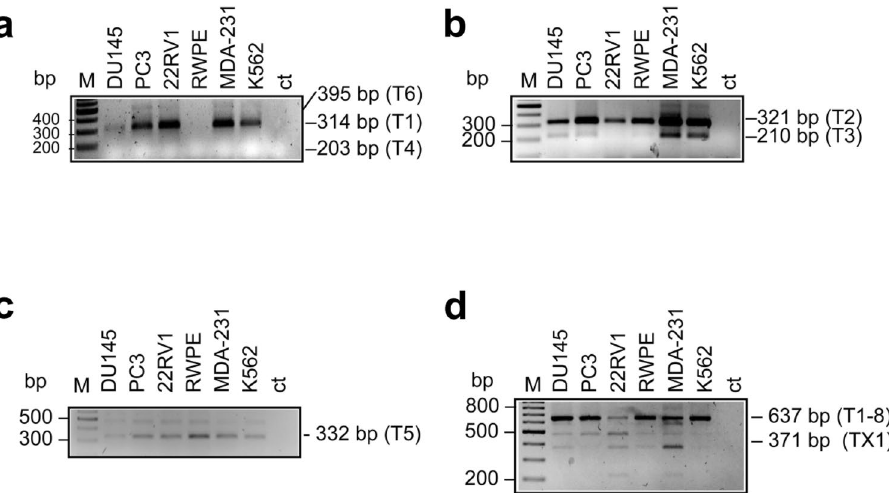
Figure 2. Specific RT-PCR for detection of the ETV4 transcripts reported in the NCBI RefSeq database in selected cell lines (Du145, PC3, 22RV1, RWPE, MDA-231 and K562). ( a ) RT-PCR to detect Transcript 1 (T1, 314 bp), Transcript 4 (T4, 203 bp) and Transcript 6 (T6, 395 bp). Primers are located in the 5’UTR common to transcripts 1, 4 and 6, and in exon 5. The 314 bp amplicon (Transcript 1) was present in all the analyzed cell lines, except RWPE, while the 203 bp (Transcript 4) and the 395 bp (Transcript 6) amplicons were not detected in any of them. The band corresponding to the 314 bp amplicon may include also Transcripts 7 and 8, which differ from Transcript 1 for the deletion of few nucleotides. ( b ) RT-PCR to detect Transcript 2 (T2, 321 bp) and Transcript 3 (T3, 210 bp). Primers are located in the 5’UTR common to transcripts 2 and 3, and in exon 5. The 321 bp amplicon (Transcript 2) was present in all the analyzed cell lines. The 210 bp amplicon (Transcript 3) was present in all the analyzed cells (faint in RWPE) but in 22RV1. ( c ) Transcript 5 (T5, 332 bp) was detected in all analyzed cells. Primers are located in the 5’UTR of transcripts 5, and in exon 5. ( d ) RT-PCR to detect Transcripts 1 to 8, but 5, (T1-8, 637 bp) and Transcript X1 (371 bp), which were present in all the analyzed cells. Primers are located in exon 6 and in exon 10. The presence of additional amplicons suggests the existence of other alternative transcripts such as ETV4 ∆7 (475 bp), see Fig. 4. Primer sequences for the specific amplification of each transcript are reported in Supplementary Table 1. Lane M is the 100 bp ladder. Sizes of the expected bands are reported on the right. Ct: reagent control.